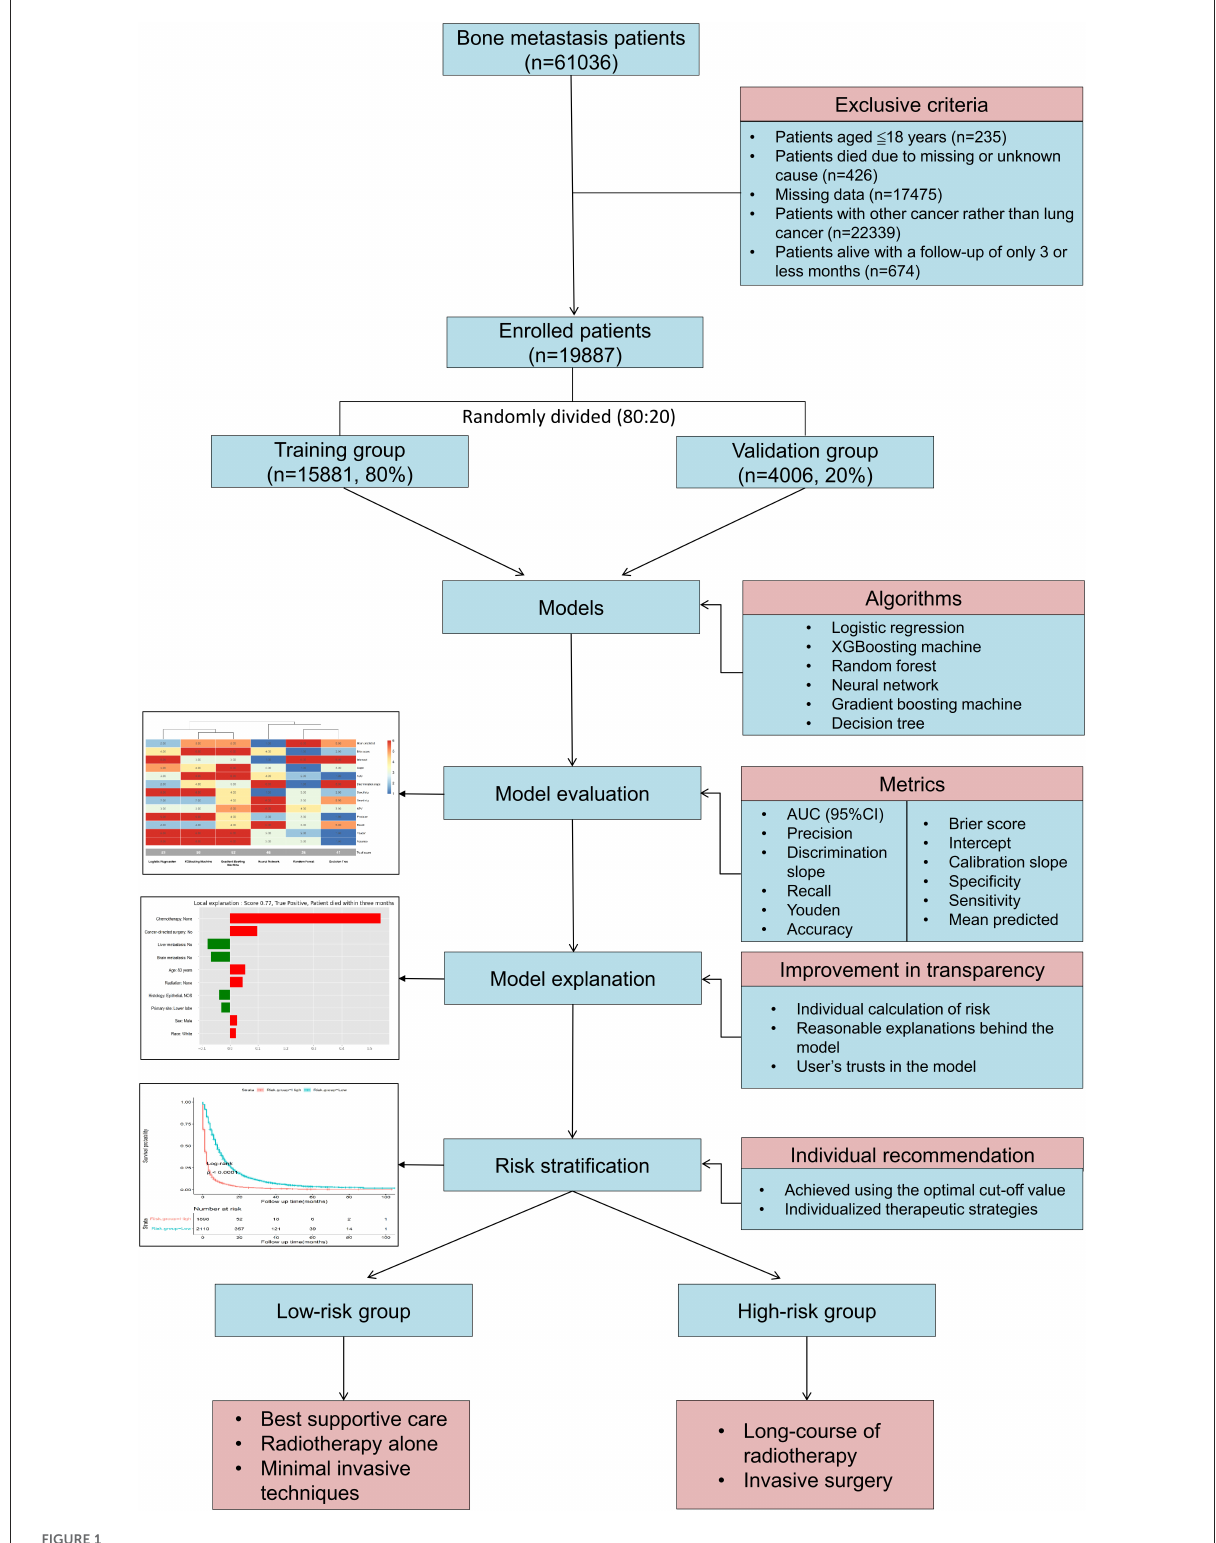
FIGURE1 Patient’s flowchart and study